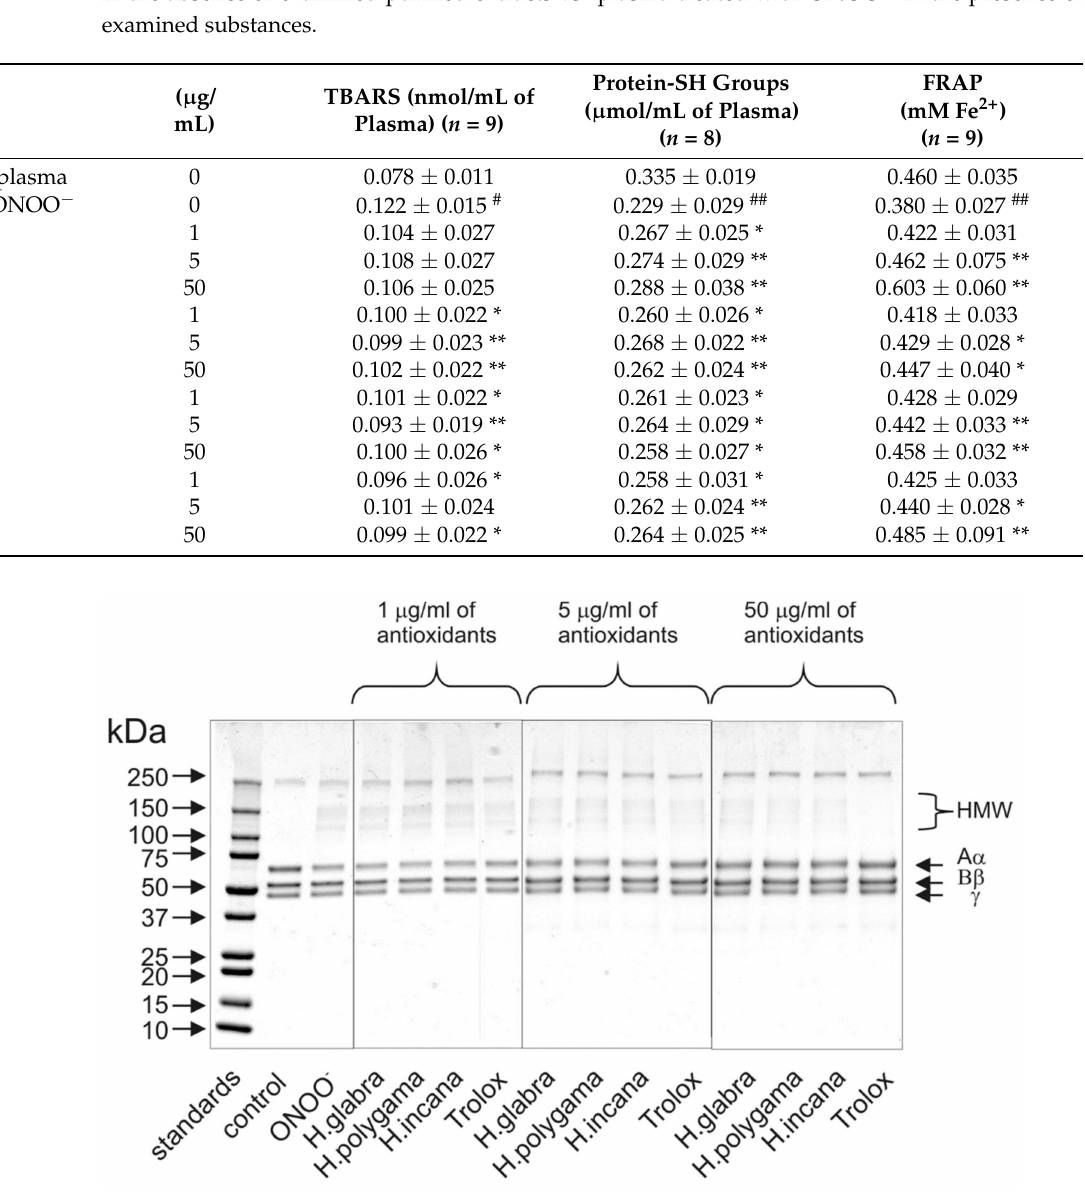
Figure 4. Protective effects of the examined Herniaria glabra , H. polygama and H. incana herb purified extracts on the ONOO − -induced oxidative changes in fibrinogen structure. The figure includes a representative SDS-PAGE pattern of human fibrinogen, obtained from the executed experiments em- ploying 4–20% Mini-PROTEAN ® TGX™ Precast Protein Gels and staining with Coomassie Brilliant Blue R-250 dye ( n =